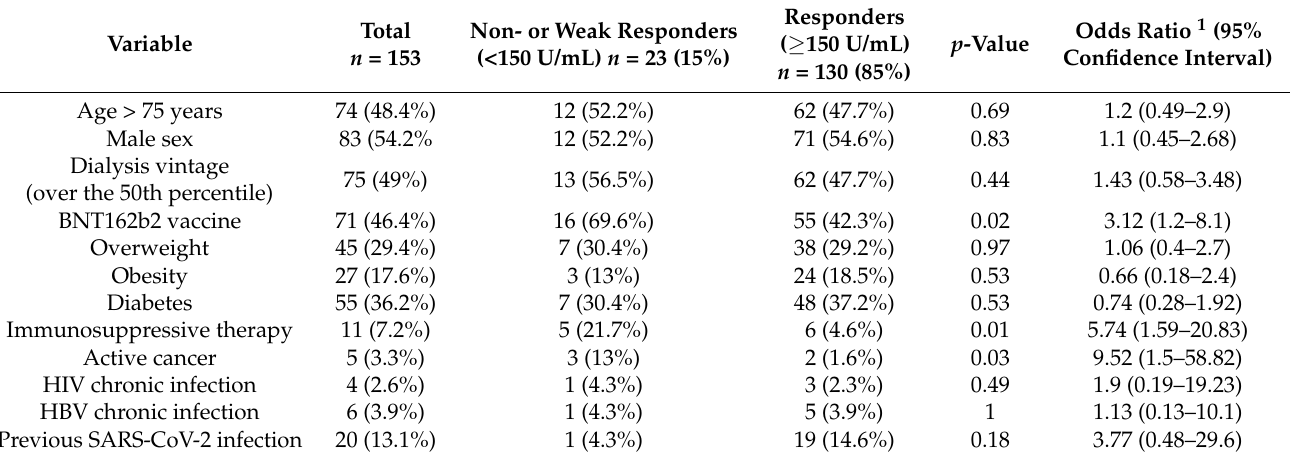
Figure 2. Percentages of non- or weak responders (anti-S1 RBG IgG levels < 150 U/mL) and respon- ders (anti-S1 RBG IgG levels ≥ 150 U/mL) to each dose of any SARS-CoV-2 mRNA vaccine. Table 2. Demographic and clinical characteristic comparisons between non- or weak responders and responders to the third SARS-CoV-2 mRNA vaccine dose.